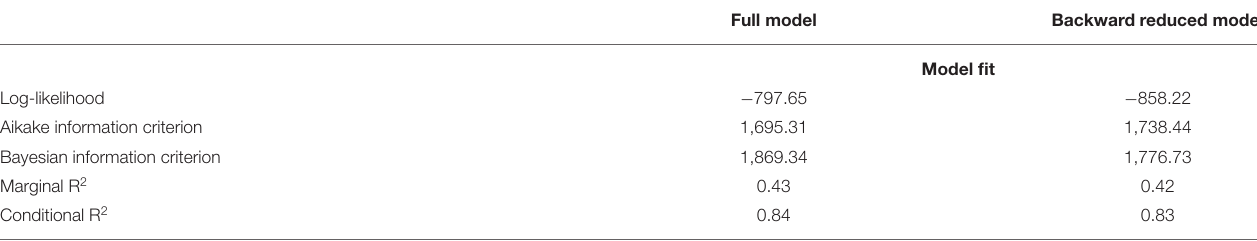
identified in the reduced model after adjustment for